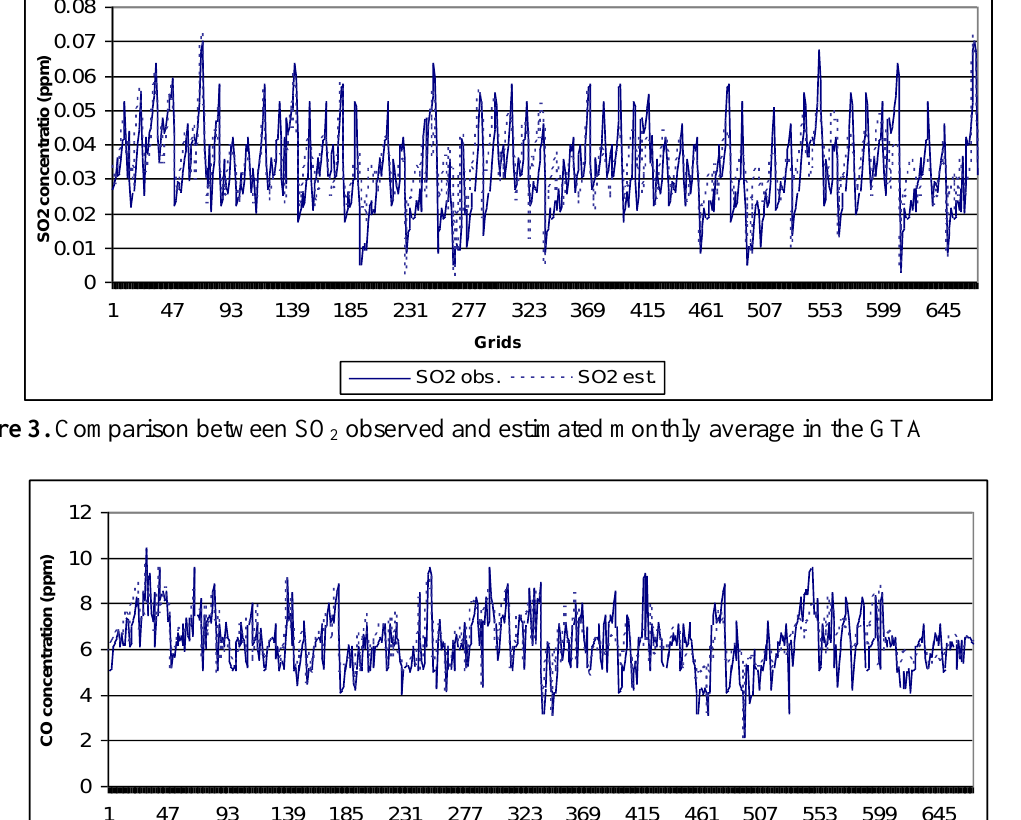
Figure 4. Comparison between CO observed and estimated monthly average in the GTA